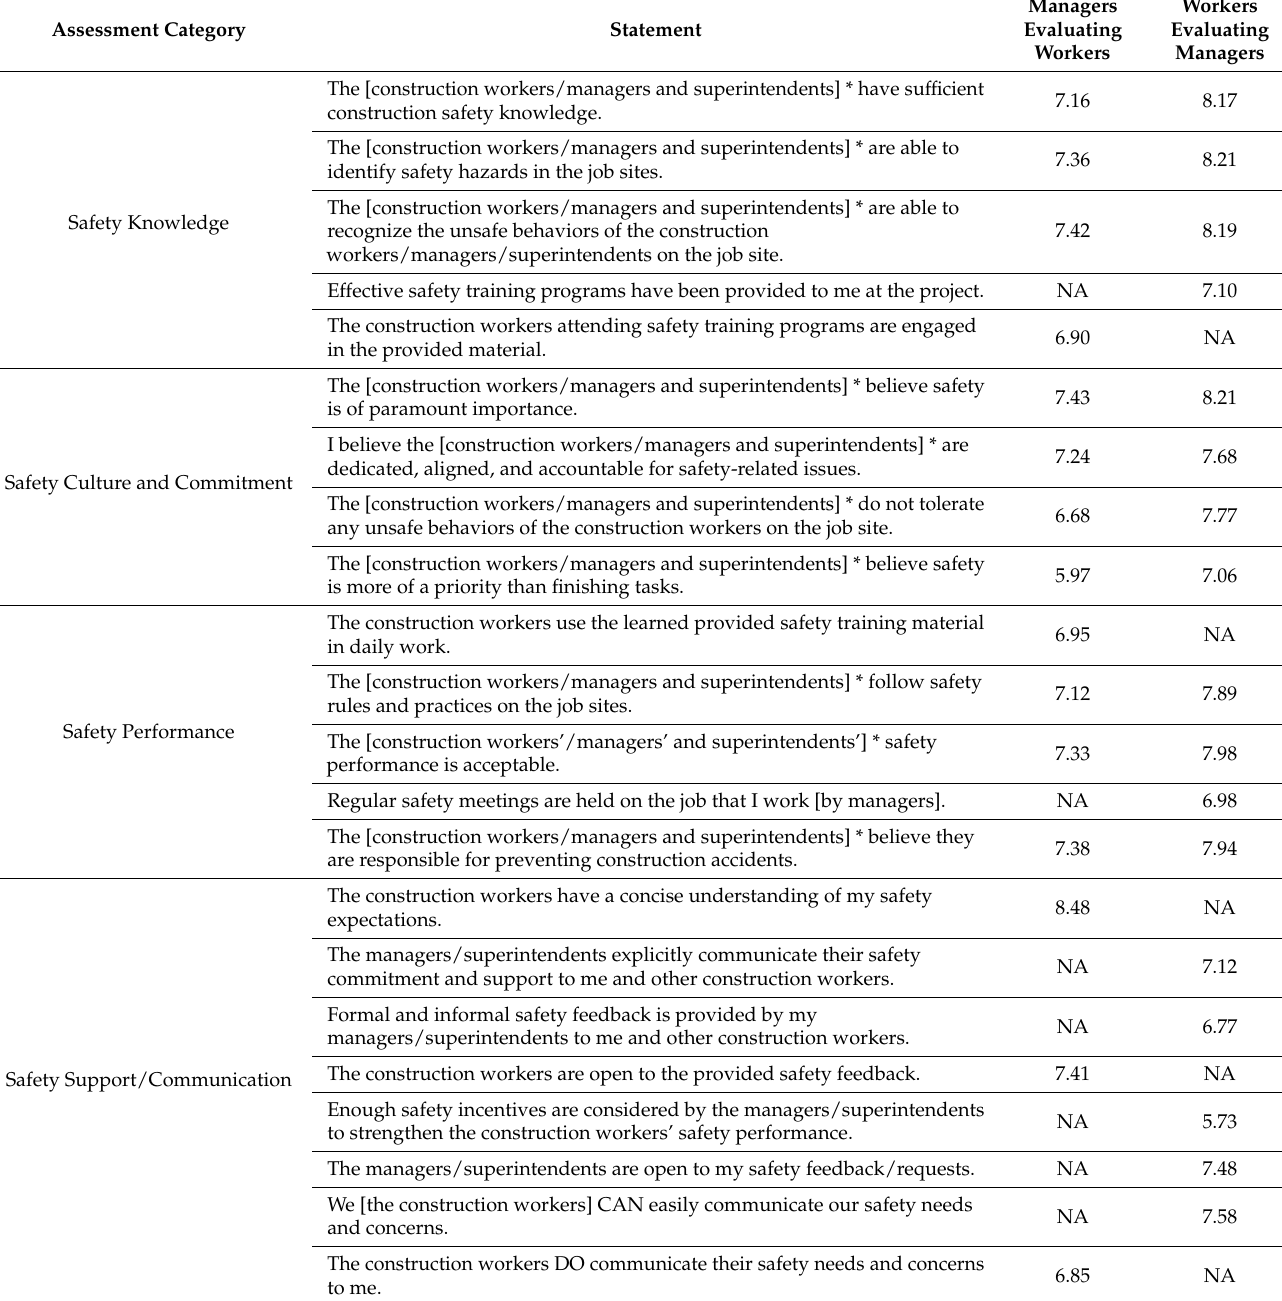
Table 5. Results of evaluation of the counterpart group for safety